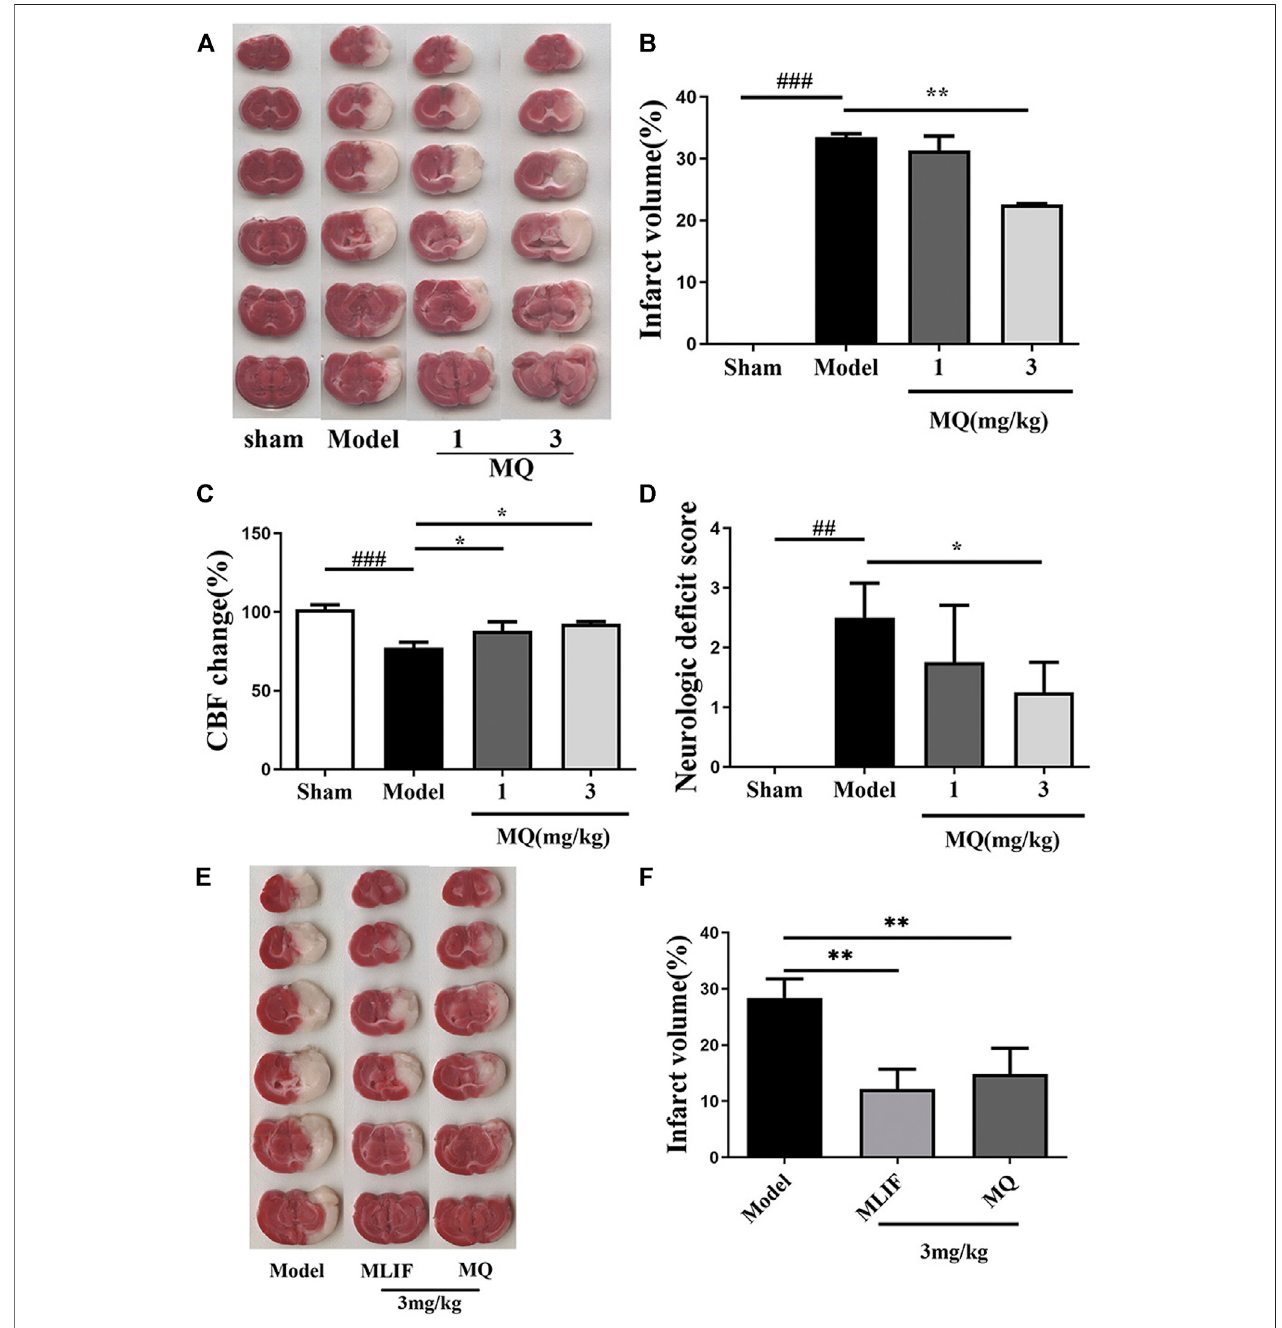
FIGURE 1 | MQ increased reperfusion CBF, decreased infarct volume, and neurological de fi cits in MCAO rats; MLIF decreased infarct volume similar to MQ. (A) TTCstainingwasusedtoassesstheinfarctareasofthebrain, (B) braininfarctareaswereanalyzedbyImageJtoestimatetheinfarctareasinthewholehemisphereafter MCAO, (C) effectofMQonthevaluesofcerebralblood fl owaftercerebralI/Rinrats, (D) effectsofMQontheneurologicalfunctionaftercerebralI/Rinrats, (E) theinfarct areas of the model group (28.42 ± 3.08%) increased dramatically compared to those of the sham group, and (F) the infarct areas of the MLIF and MQ (11.55 ± 3.81%, 14.85 ± 4.20%) decreased signi fi cantly compared to the model group. ### p < 0.001, Model group vs. Sham group; * p < 0.05, ** p < 0.01, MQ group vs. Model group, n ≥ 3.